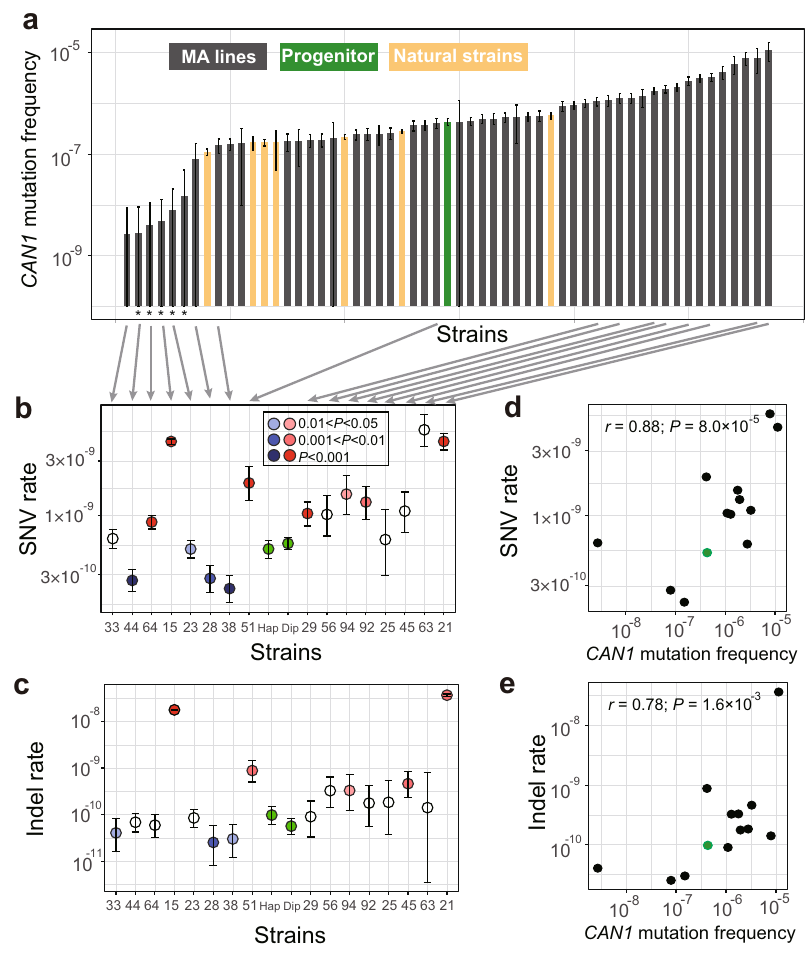
Fig. 2 Mutation frequencies and rates of the MA lines. a CAN1 mutation frequencies of the progenitor (green), 49 MA lines (gray), and 7 natural yeast strains (yellow), determined by the fl uctuation test based on 72 (green and gray) or 288 (yellow) biologically independent cell cultures from each strain. The data from the seven natural strains came from ref. 14 . Error bars indicate 95% con fi dence intervals of the mean. “ * ” on the X -axis indicates diploid or putatively diploid strains. Mutation frequency is the probability of loss-of-function mutation in CAN1 per cell division, so is not directly comparable with the mutation ratesestimatedbyMA+WGS.SNV( b )orindel( c )mutationratepersite per generation in the progenitor in both haploid and diploid form (green) and 16 MA lines estimated by MA+ WGS based on 4 to 20 biologicallyindependentreplicates.Numberson the X-axisrefertoIDs